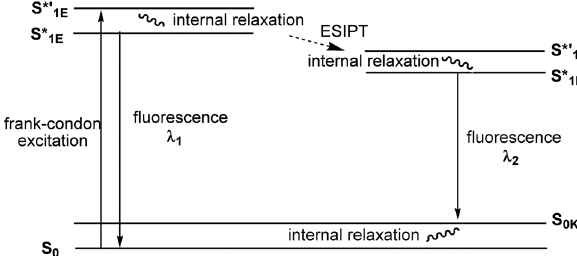
Figure 4: The mechanism of ESIPT fl uorescence in the nonpolar